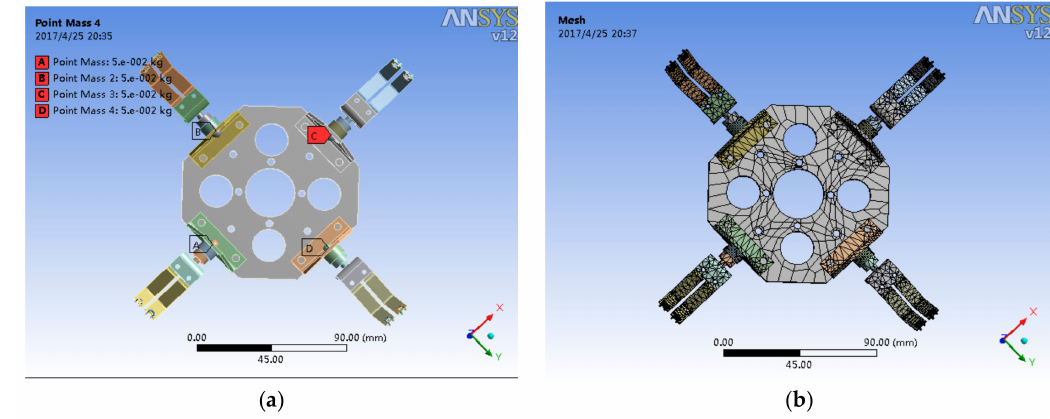
Figure 10. Finite element models. ( a ) Finite element model of the grasping claws module; ( b ) Mesh plot of the grasping claws